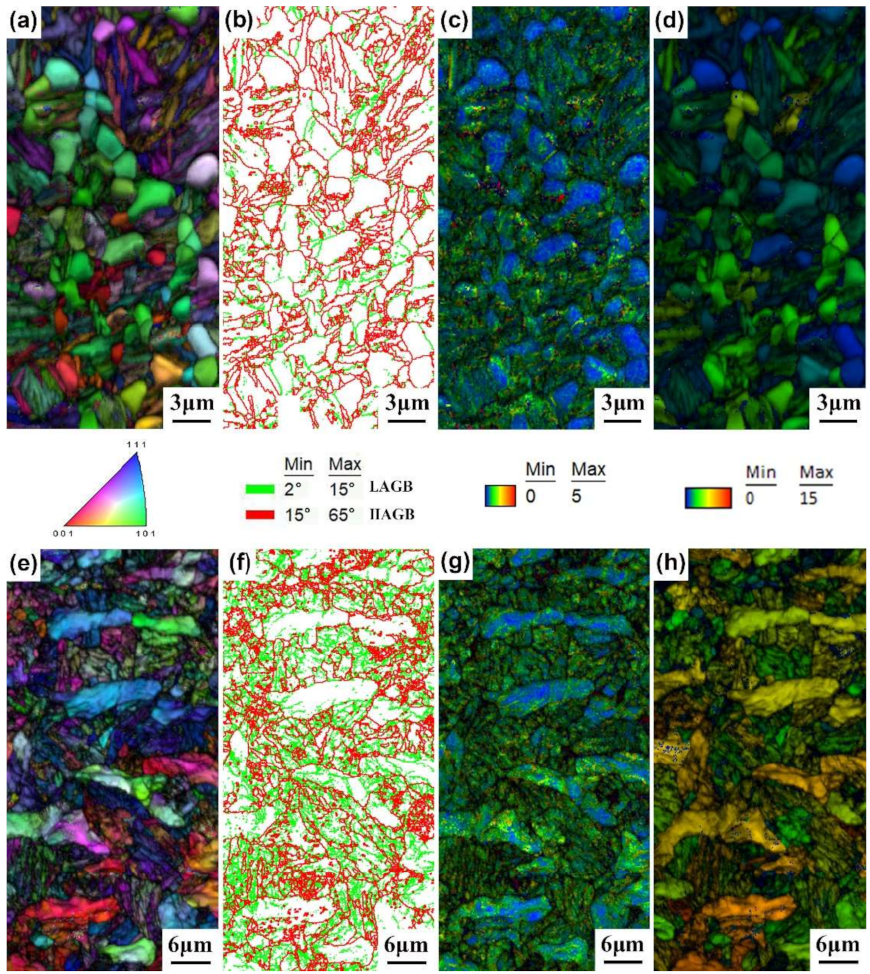
Figure 7. EBSD images of the ( a – d ) 0.33C steel and ( e – h ) 0.21C steel after above- Ms austempering.